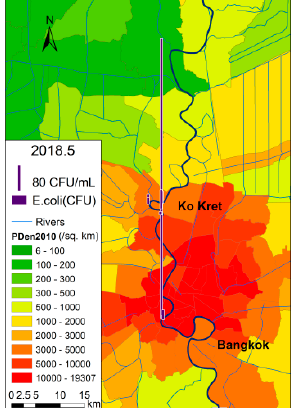
Figure 9. The spike of E. coli at a downstream site.